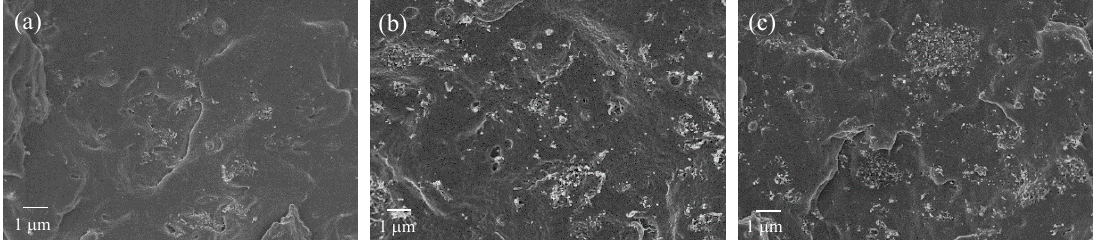
Figure 6. (a) PP/CNT ‐ 3, (b) PP/CNT ‐ 5 and (c) PP/CNT ‐ 7 Figure 6. ( a ) PP / CNT-3, ( b ) PP / CNT-5 and ( c ) PP / CNT-7.